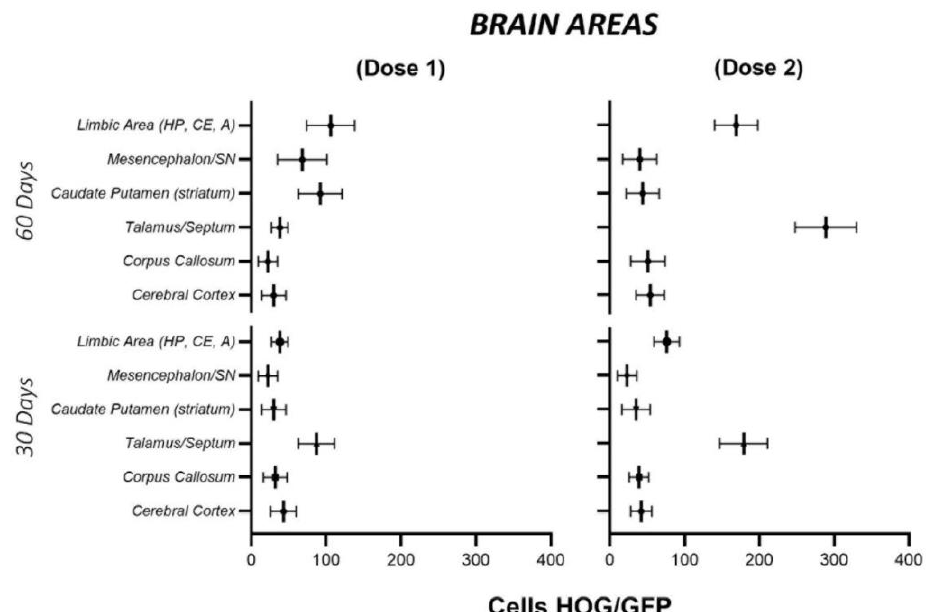
Figure 5. Quantitative analysis of the distribution of GFP-labelled HOG cells in different brain areas. For both doses, higher cell density was observed in the areas adjacent to the hippocampal circuit and the septum. Data are expressed as means + SE.